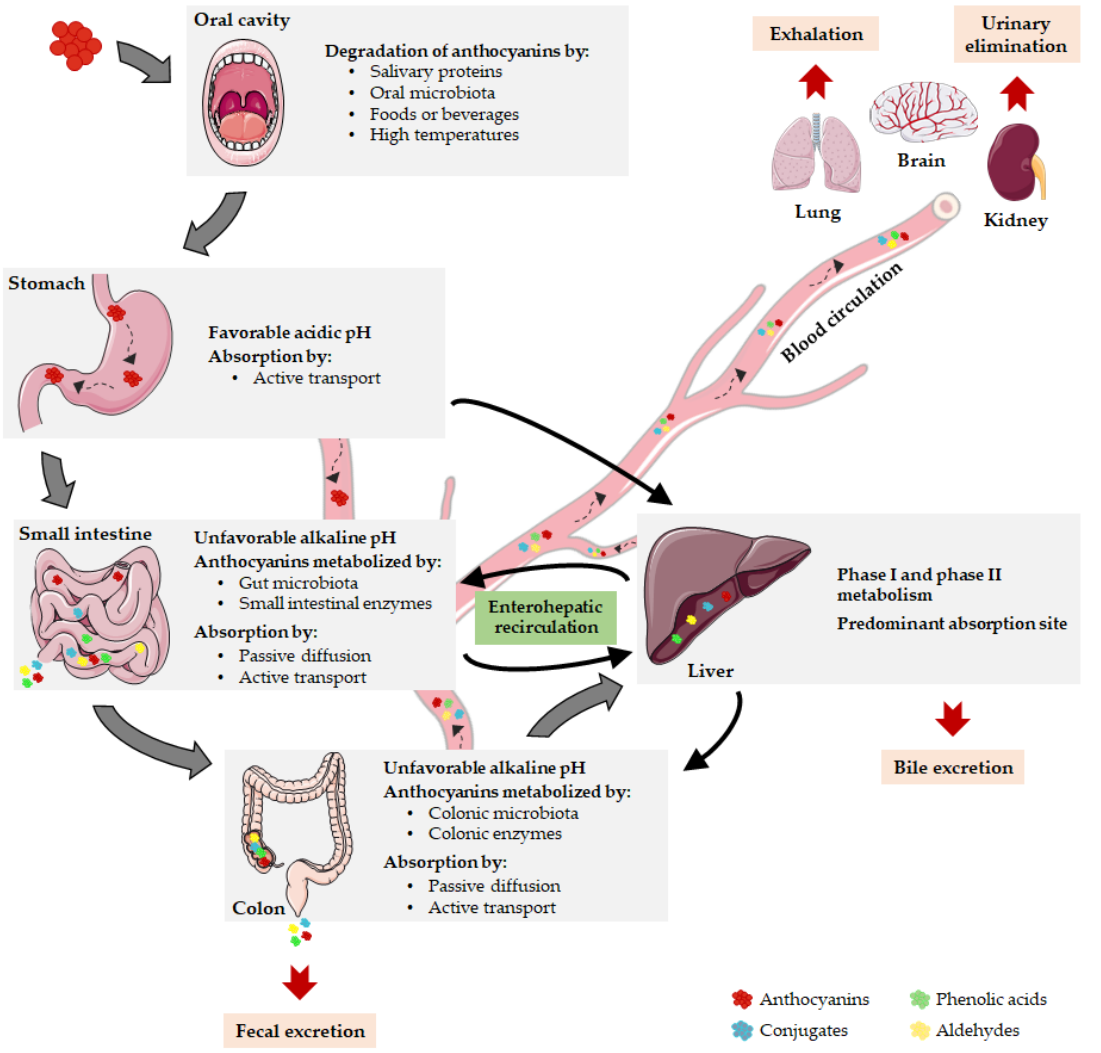
Figure 2. Pharmacokinetic properties of anthocyanins. After oral ingestion, anthocyanins can be degraded in oral cavity or reach the stomach, where they are stable due to gastric acidity. Here, they